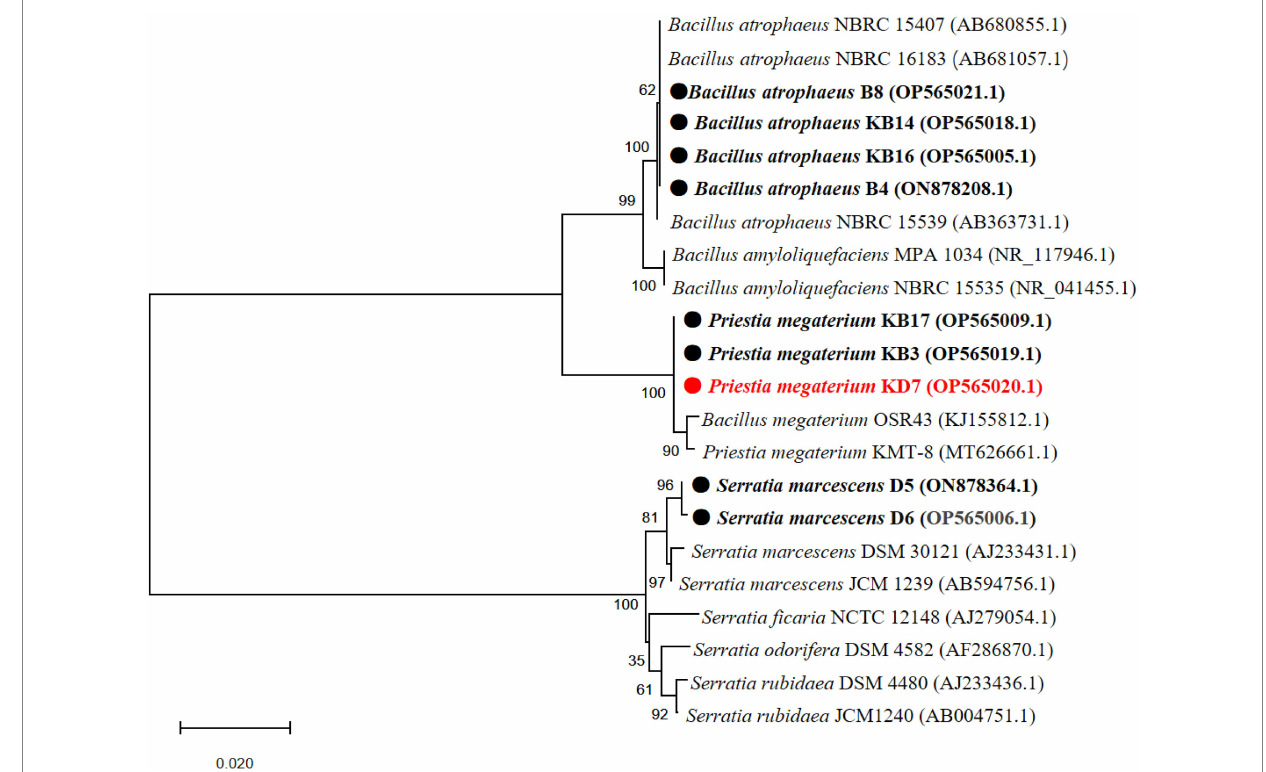
FIGURE 2 Phylogenetic tree of nine antagonistic bacteria isolates with related species on the basis of partial 16S rDNA sequences. The analysis was conducted with MEGA 4.0 using neighbor-joining method with 1,000 bootstrap replicates.